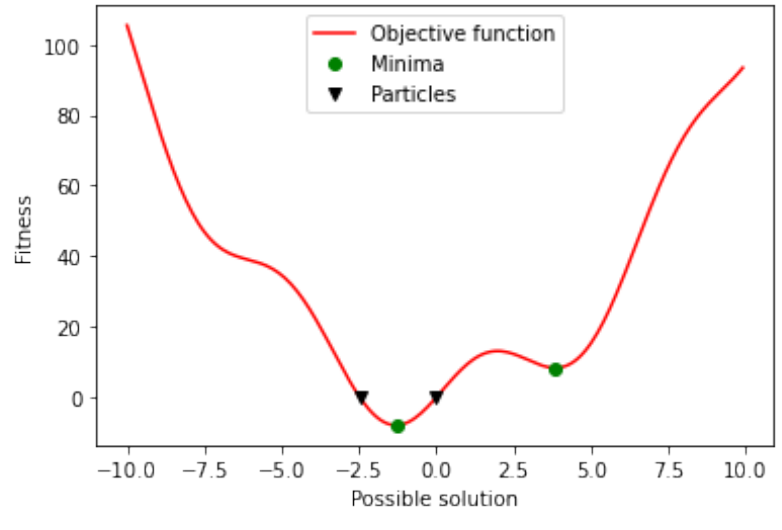
Figure 6. Function minimum.